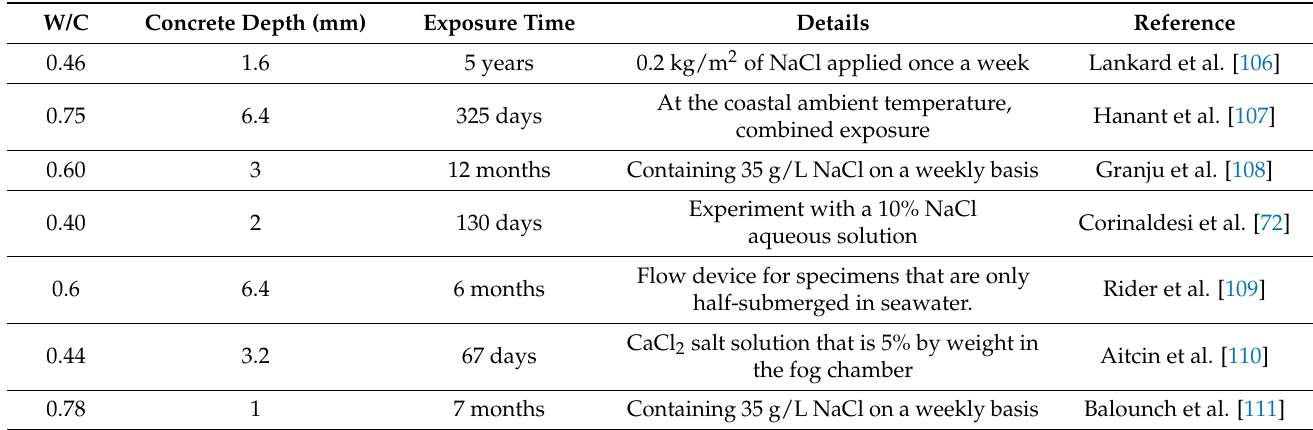
Table 1. Depths at which corrosion affects the fibers in the concrete.